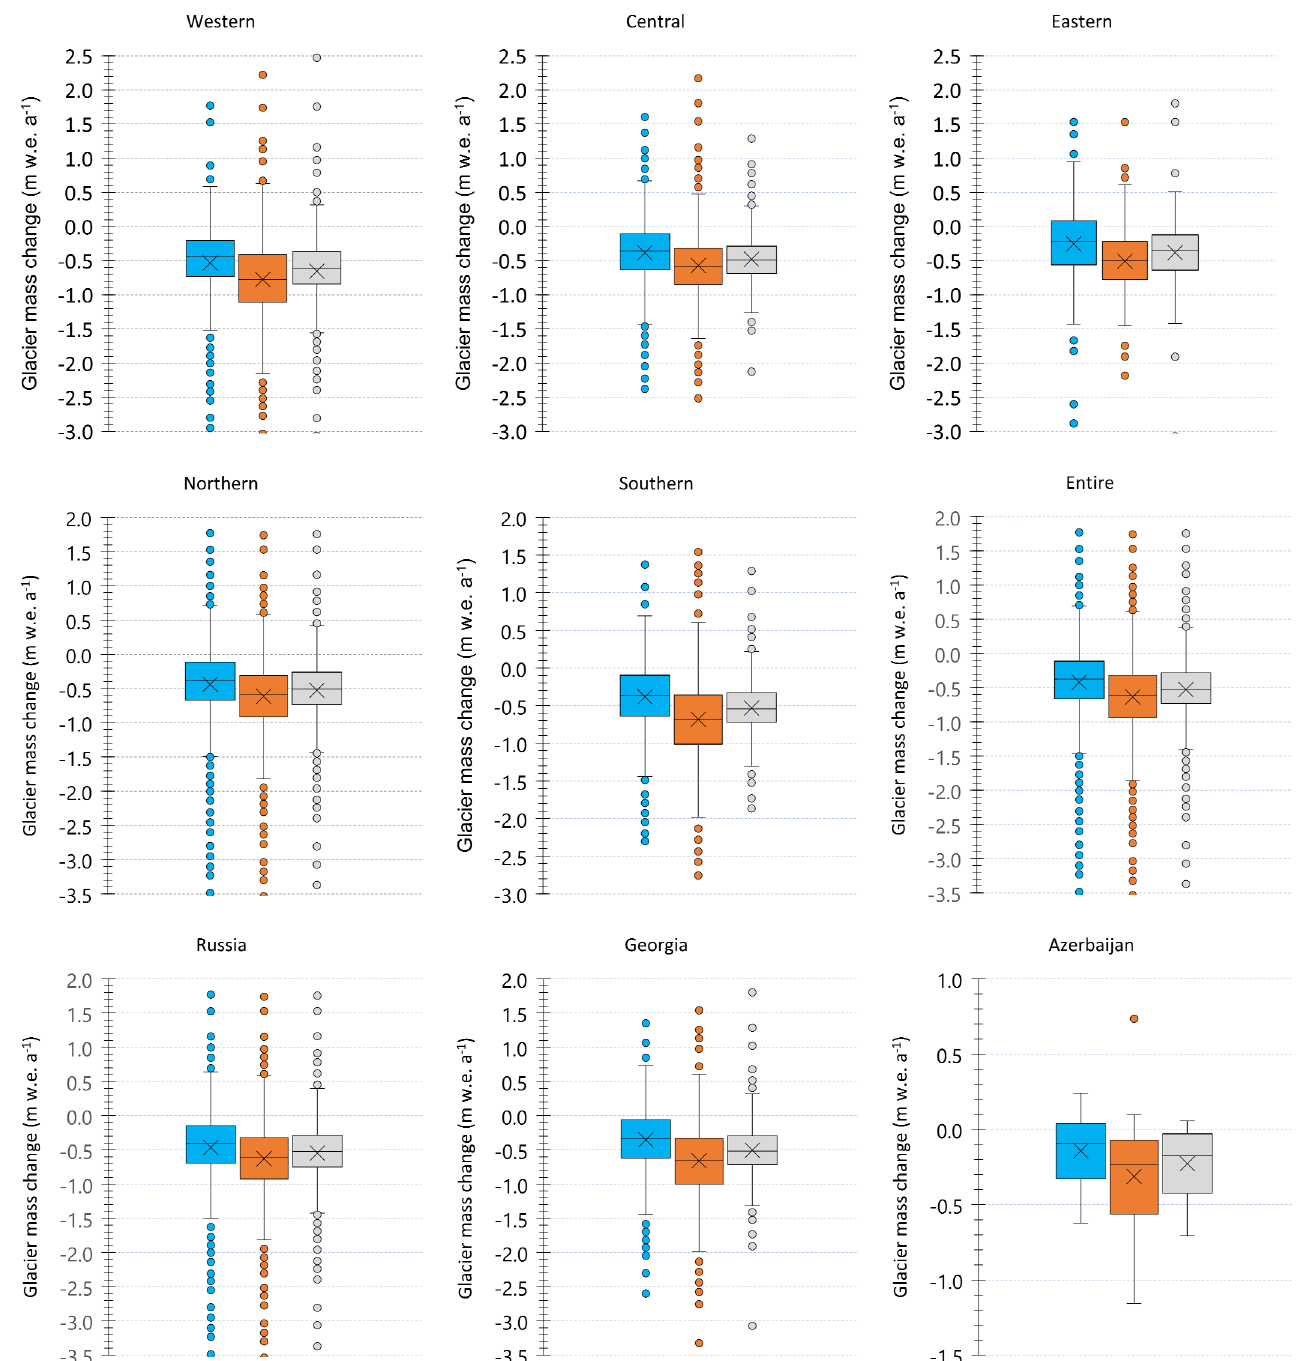
Figure 4. Boxplots based on data of the individual glaciers showing changes in glacier annual geodetic mass balance (m w.e. a − 1 ) for all Caucasus glaciers according to the regions (western, central, and eastern), slopes (northern, southern, entire) and countries in 2000–2010 (blue), 2010–2019 (brown), and 2000–2019 (grey). Box gives lower and upper quartiles (vertical stems) along with the mean (black horizontal line inside of the box) and median (X symbol inside of the box) value of glacier mass change rate. The circles correspond to the outliers.